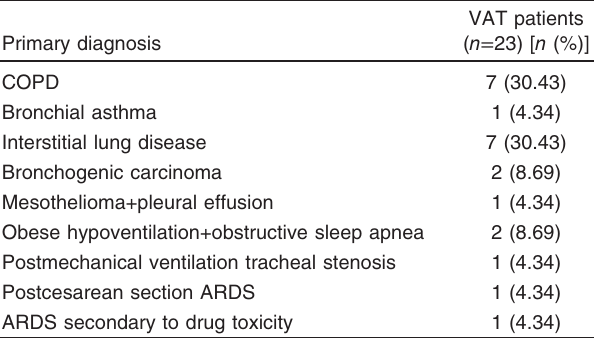
Table 2 Primary diagnoses of ventilator-associated tracheobronchitis patients